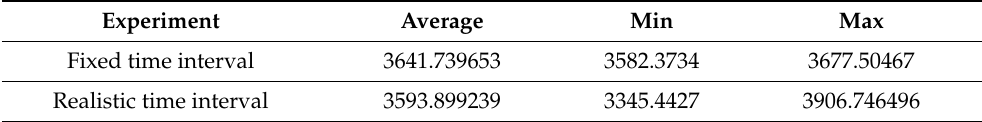
Table 4. Throughput average and limits.